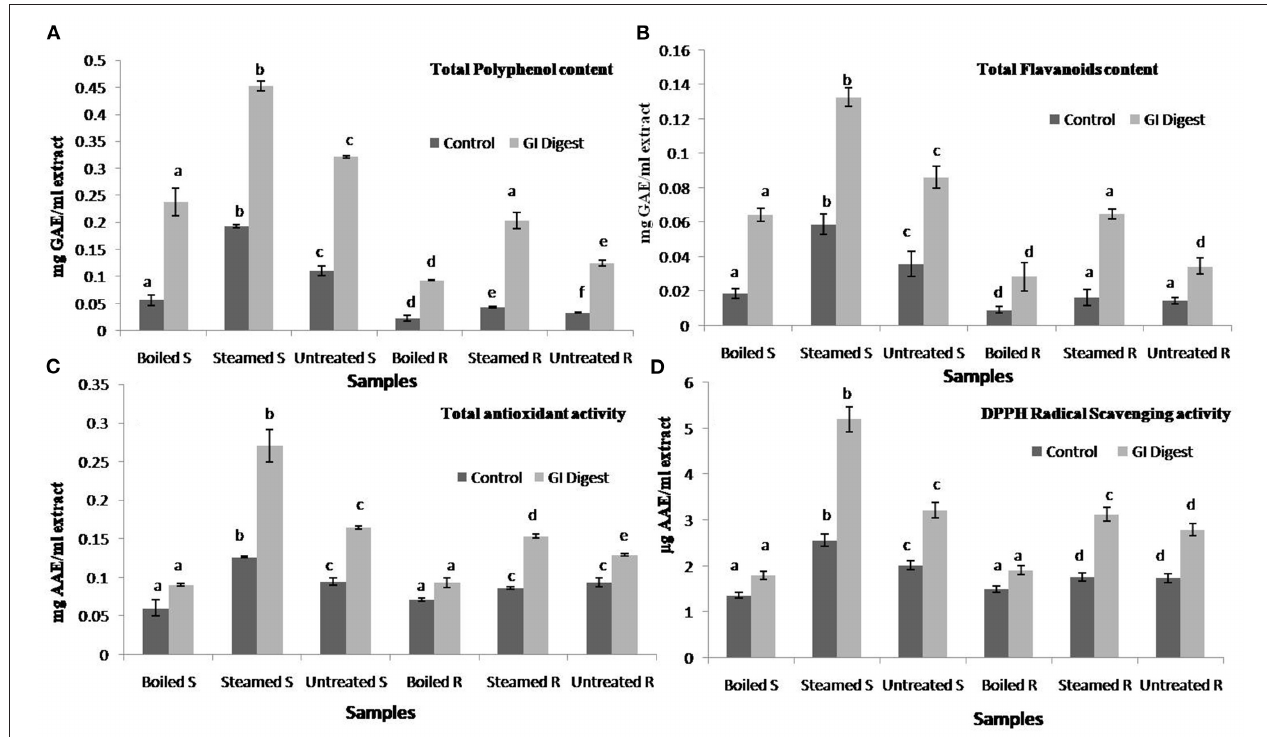
FIGURE 4 | Effects of simulated gastrointestinal (GI) digestion on Urtica dioica leaves cooked by different methods (steaming and boiling) on (A) phenolics (mg GAE/ml of GI digested extract), (B) flavonoids content (mg QE/ml of GI digested extract), (C) total antioxidant activity (mg AAE/ml of GI digested extract), and (D) DPPH radical scavenging activity ( µ g AAE/ml of GI digested extract). Boiled S, boil cooked supernatant; Steamed S, steam-cooked supernatant; Untreated S, raw supernatant; Boiled R, boiled cooked residue extract; Steamed R, steam-cooked residue extract; Untreated R, raw residue extract. Values not sharing common alphabets within the same pattern are significantly different ( p <